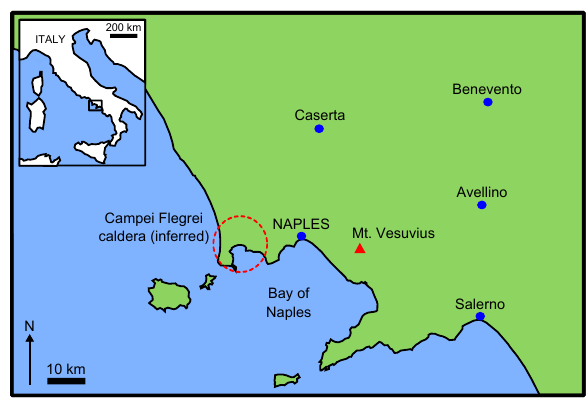
Fig. 1. Map showing the location of the inferred Campi Flegrei caldera and the proximity of Naples to both the Campi Flegrei caldera and Mt. Vesuvius. The Neapolitan Yellow Tuff used in this study was sourced from an open quarry within the inferred CF caldera at Monte San Severino (i.e. within the red circle), while the Grey Campanian Ignimbrite was sourced from an open quarry to the north-west of the town of Caserta (the blocks used in this study are the same as those used in Heap et al.,